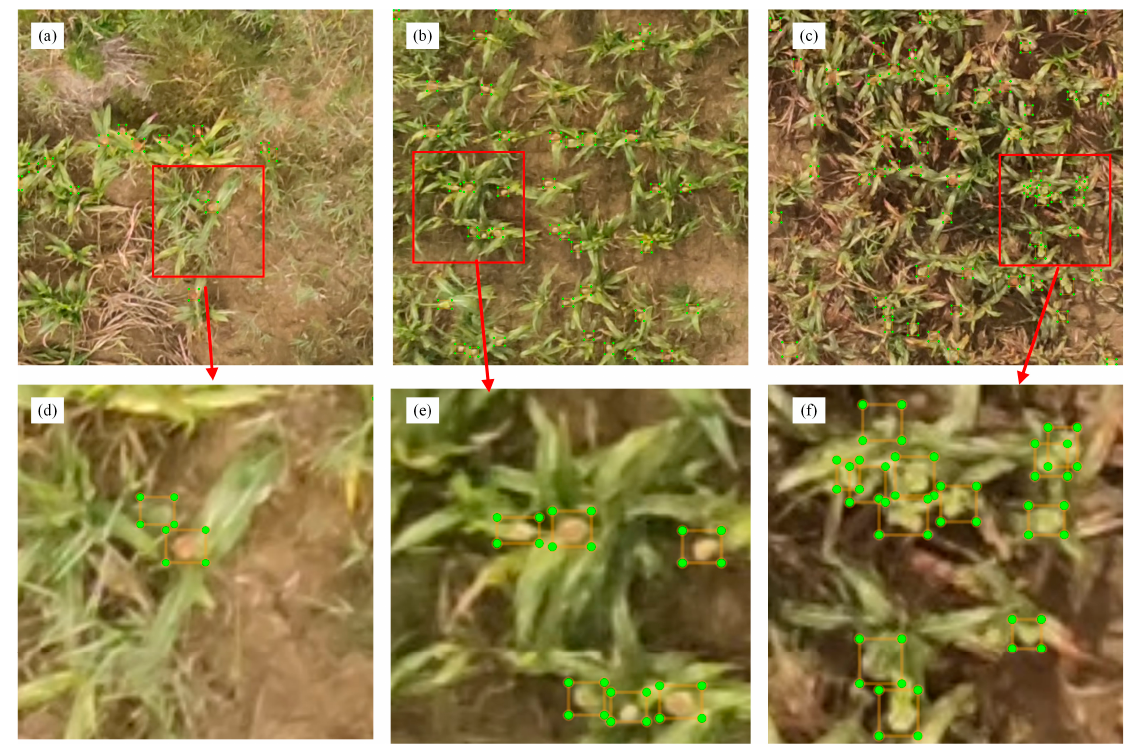
Figure 2. Example of labeling and corresponding local zoomed-in images for different densities of sorghum heads (( a – c ) represents sparse, moderate, and dense conditions, and ( d – f ) represents the corresponding local magnified images, respectively).